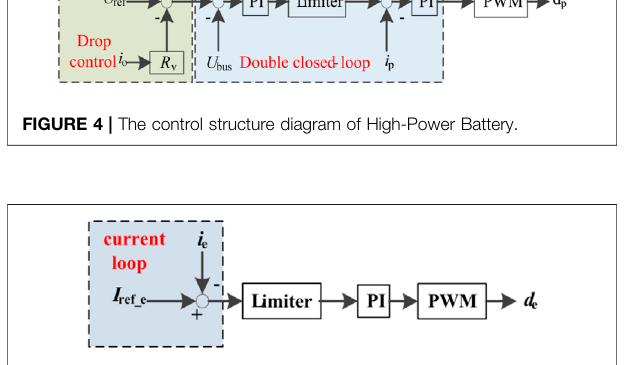
Figure 6 is the control structure diagram of LPF-based.